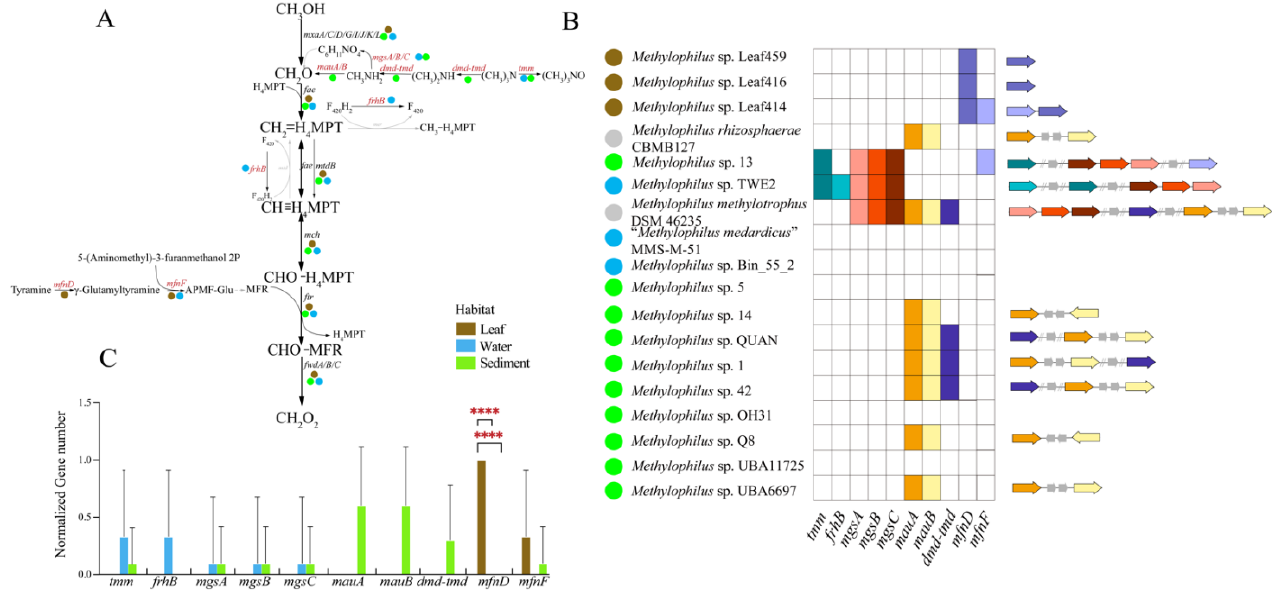
Figure 5. ( A ) Methanol metabolic pathway. Each step of the reaction is tagged with the corresponding genes. Genes that are present in all genomes are highlighted in black, while those that are present in partial genomes and absent in all of the genomes are highlighted in red and grey, respectively. ( B ) Distribution of partial methanol metabolism genes in Methylophilus genomes. The colored boxes indicate that the gene is present in the genome, whereas the white box indicates that it is absent. A functional gene clusters structural plot was performed according to the heatmap. The colored arrows correspond to the colored boxes. The grey arrows represent unknown genes. The solid circles with colors, blue, brown, green and grey, represent isolation sources, water, leaf, sediment and others, respectively. ( C ) Histogram constructed by computing the normalized number of partial methanol metabolism genes involved in ( B ). Three box colors represented three environments. Significant differences in mfnD gene between leaf versus water and leaf versus sediment by one-way ANOVA. ****: p < 0.00001.